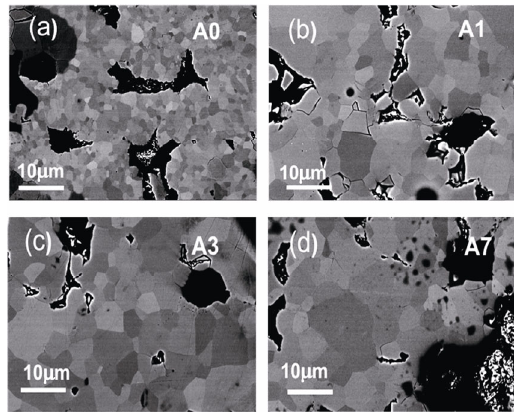
Fig. 6 BSE images of the samples A0, A1, A3, and A7.